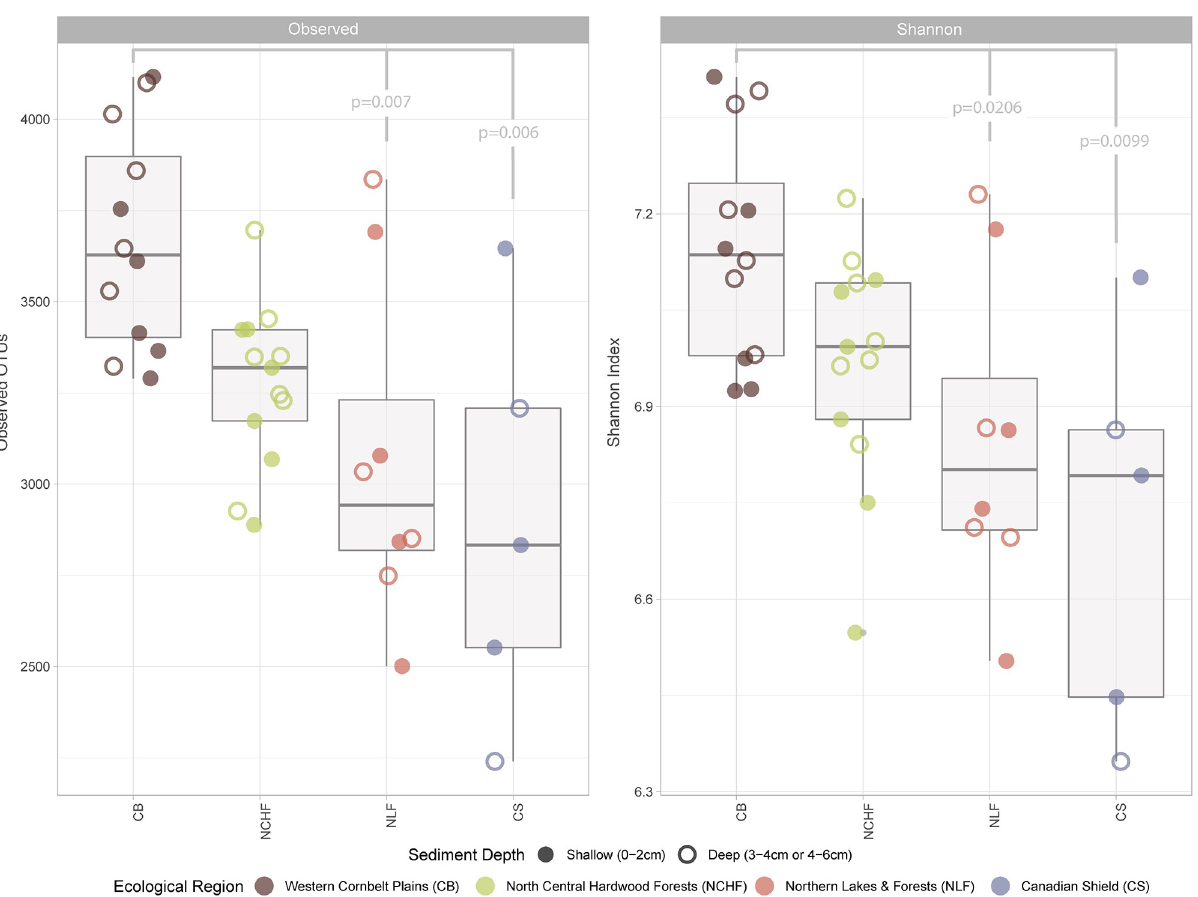
Fig 2. Bacterial alpha diversity by ecological region. Box plots show mean alpha level diversity of the observed Operational Taxonomic Units (OTUs) and Shannon indices of the four distinct ecological regions present within the study area: Western Cornbelt Plains (CB), North Central Hardwood Forests (NCHF), Northern Lakes and Forests (NLF), and Canadian Shield (CS). Open (shallow) and closed (deep) circles indicate unique samples and color indicates the ecological region. One sample was removed from both plots for due to uncharacteristically low diversity. Significance between regions was calculated nonparametrically using a Kruskal Wallis H test followed by a Dunn post hoc test with a Bonferroni correction. Reported p values indicate significant differences in Observed and Shannon diversity (respectively) across ecological regions, specifically the diversity of CB lake sediments when compared to NLF (p = 0.007 & p = 0.0206) and CS (p = 0.006 & p = 0.0099) sediments.